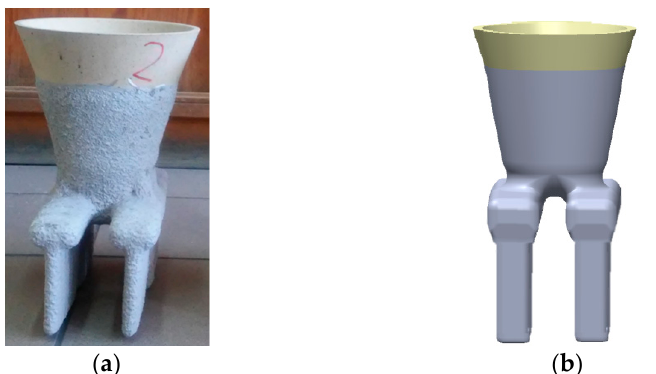
Figure 1. Casting mould (lower part) combined with the casting bowl (upper part): ( a ) The actual mould; ( b ) the digital twin mould in the form of a CAD (Computer Aided Design) model. The role of the digital twin is to reproduce the geometrical features and mass of the object. The real object and the digital twin show some differences, e.g., in the proportions of the lower and upper parts. They result from the fact that the lower part of the casting mould is not very repeatable, because it consists of seven layers manually applied with the use of binders. The digital twin takes into account the largest possible dimensions of the object.